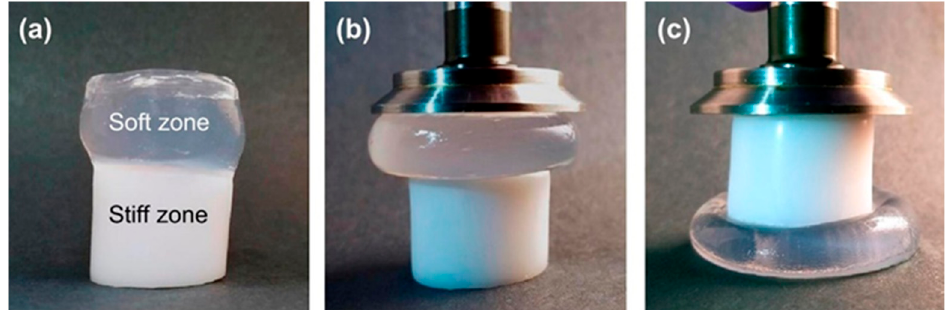
Figure 10. Figures showing the behavior of soft − sti ff hybrid gels under compression: ( a ) initial hydrogel before compression, ( b , c ) compressed hydrogel by rheological plate geometry [10].